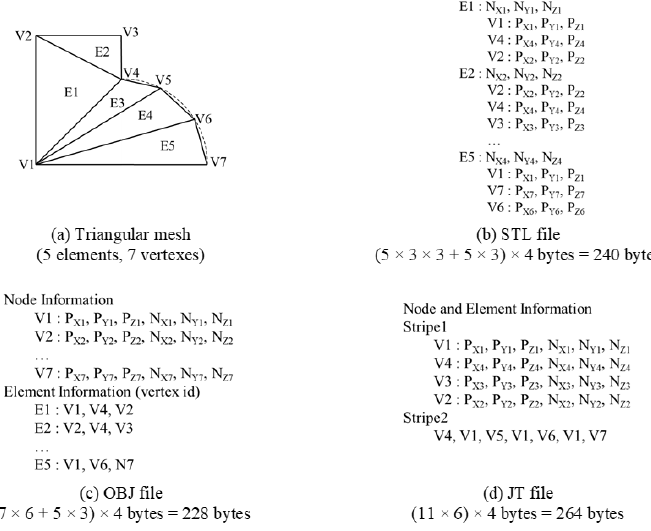
Figure 4. Comparison of data sizes for different lightweight file structures: ( a ) triangular mesh, ( b ) STL file, ( c ) Wavefront object (OBJ) file, and ( d ) Jupiter Tessellation (JT) file.